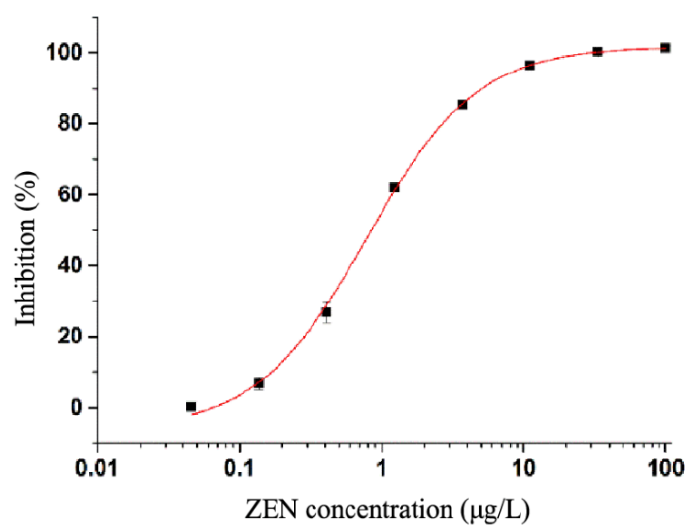
Figure 1. Standard curve of ZEN by ic-ELISA.